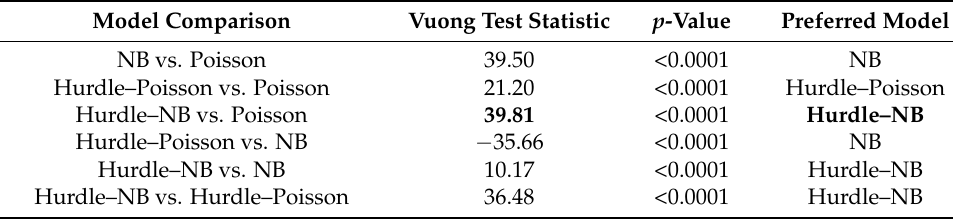
Table 4. Model comparison using the Vuong test.